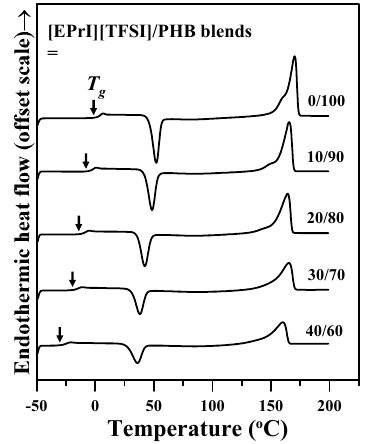
Figure 2. DSC thermograms of [EPrI][TFSI]/PHB blends with various compositions (wt %).